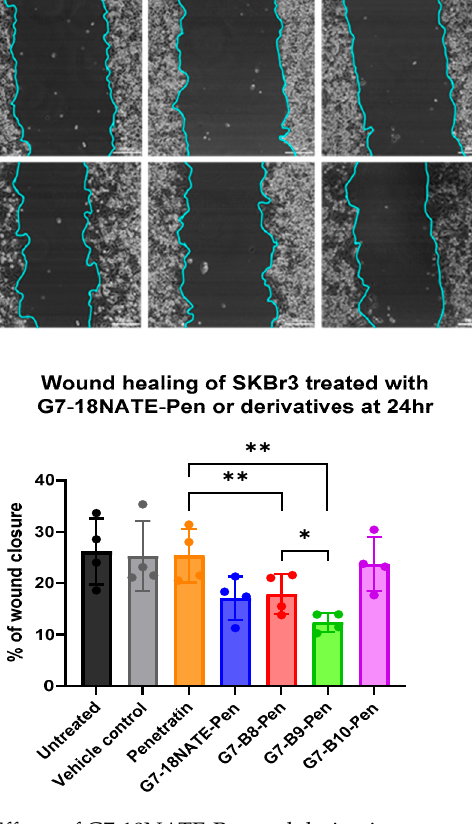
Figure 4. Effects of G7-18NATE-Pen and derivatives upon wound healing of SKBr3 cells. (top) Cells were plated as a confluent monolayer, and a wound was created to assess the extent in which the newly developed peptides could inhibit cell migration. The cells were treated with either complete medium (untreated), a vehicle control (sterile PBS), 20 µM control peptide (Penetratin), or 20 µM Grb7-SH2 inhibitor (G7-18NATE-Pen, G7-B8-Pen, G7-B9-Pen, and G7-B10-Pen). Cell migration and wound closure were monitored in real time, and images were captured every 15 min for 24 h. Representative images of wound closure of SKBr3 at 0 h and 24 h. Scale bar is equal to 200 µm. (bottom) Percentage of wound closure was calculated over 24 h and paired t-tests were performed without correction. Error bars represent the mean ± SD (n = 4), * = p ≤ 0.05, ** = p ≤ 0.01.